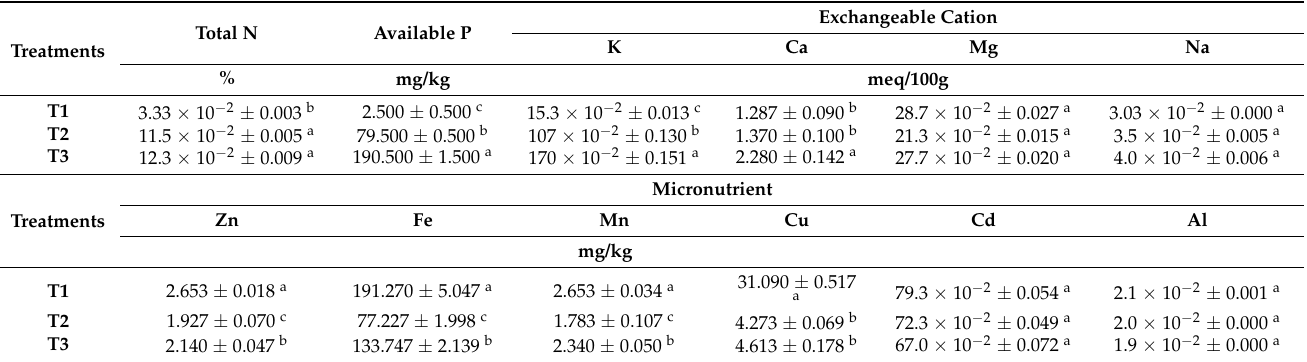
Table 1. The effects of different treatments on the chemical properties of soil.